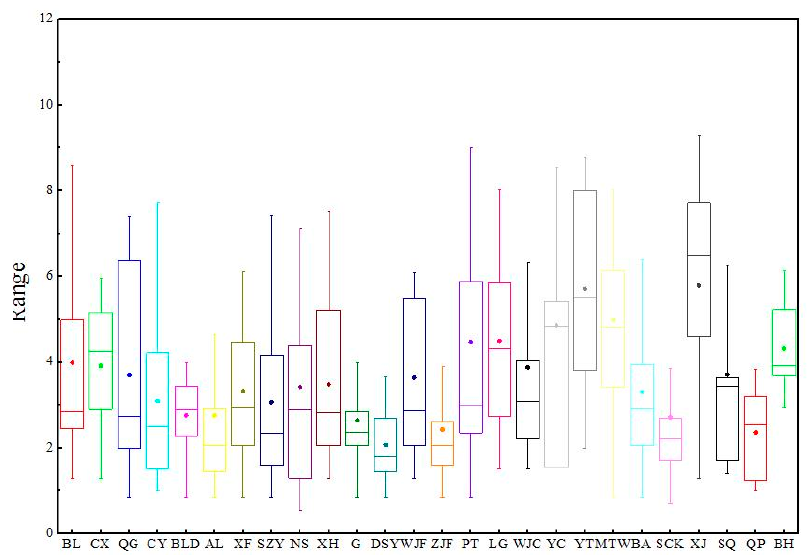
Figure 6. Evaluation of household hollowing.